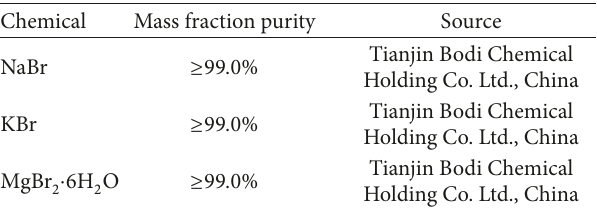
Table 1: Purities and suppliers of chemicals. Chemical